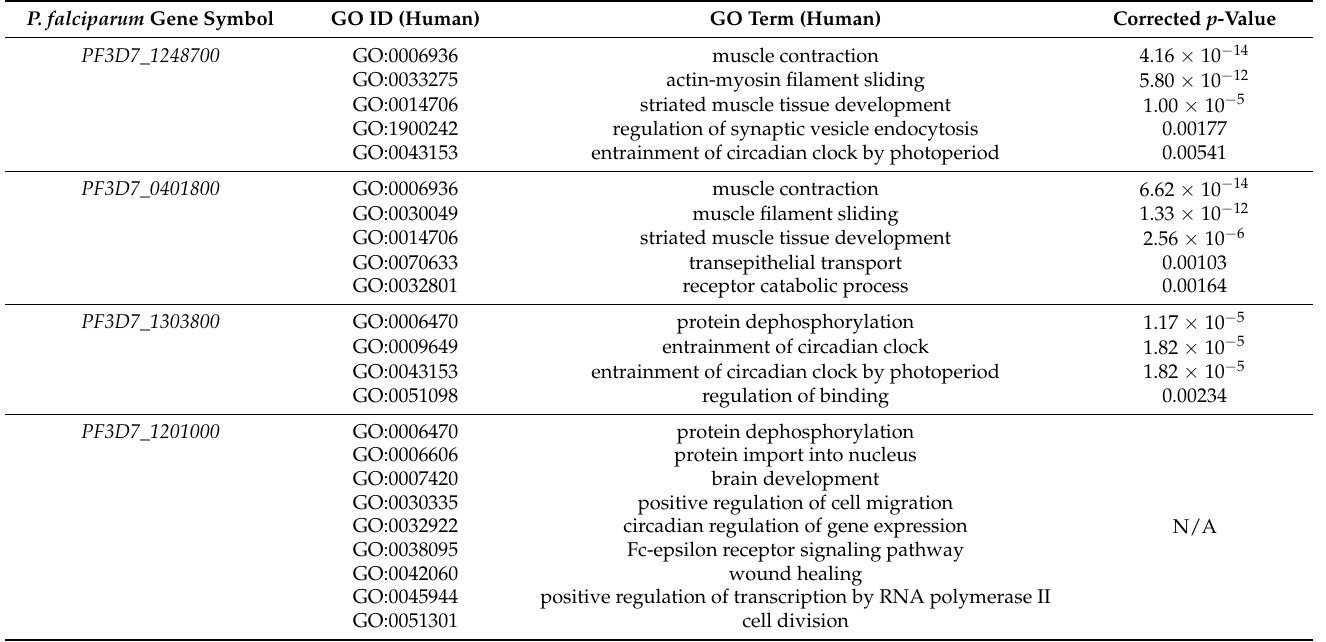
Table 2. The predicted gene functions for selected P. falciparum